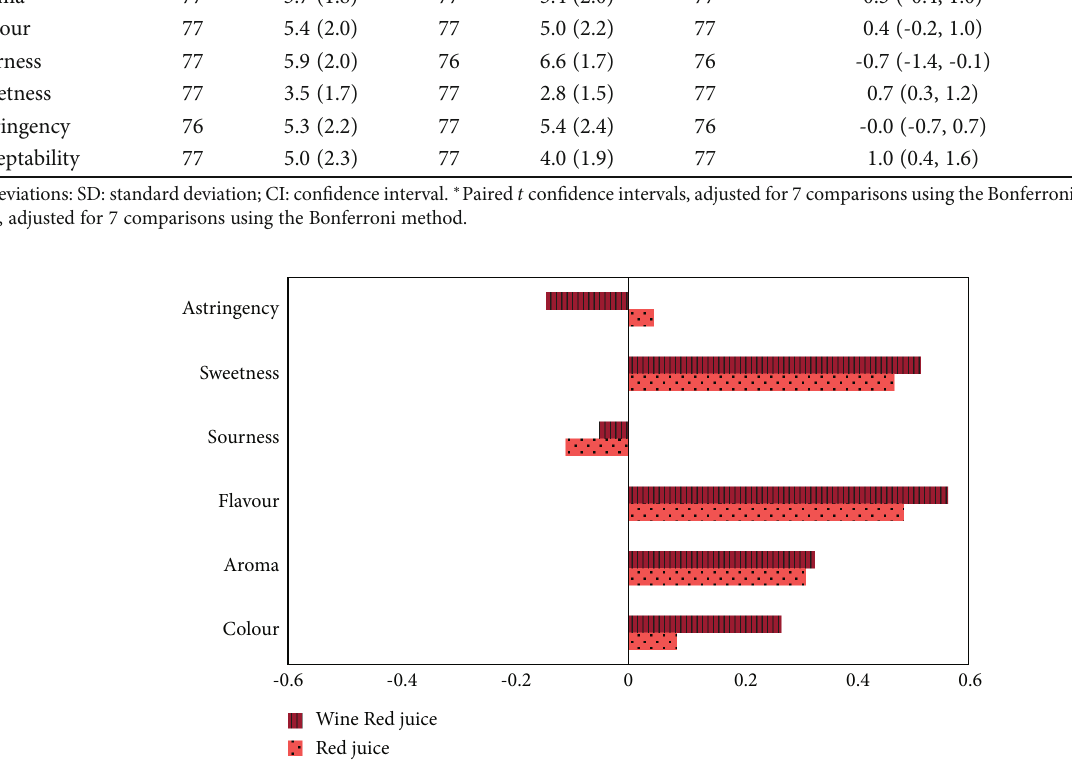
Figure 1: Correlations of sensory attributes with